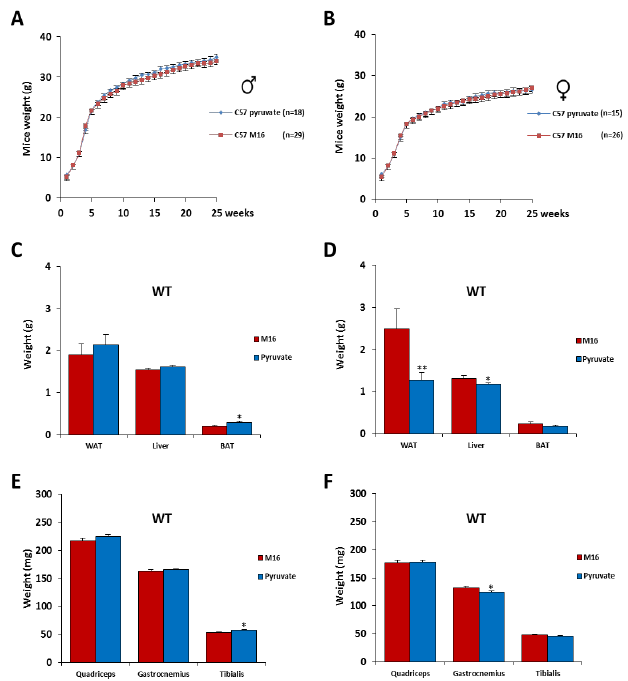
Figure 2. Post-natal growth of C57Bl/6J mice was not affected by a short exposure in M16/pyruvate medium at 1-cell embryo stage. Post-natal growth profiles of male ( A ) and female ( B ) C57Bl/6J mice derived from zygotes incubated in M16 or M16/pyruvate media. At 6 months of age, the mice were sacrificed, and white adipose tissue (WAT), brown adipose tissue (BAT), and liver were weighed ( C ): male; ( D ): female, as well as the skeletal muscles (quadriceps, gastrocnemius, and tibialis) ( E ): male; ( F ): female. For male C57Bl/6J mice, n = 18 in M16 medium and 29 in M16/pyruvate medium. For female C57Bl/6J mice, n = 15 in M16 medium and 26 in M16/pyruvate medium. Statistical significance: * p < 0.05, ** p < 0.01, Student’s t -test. Results are expressed as ± sem.